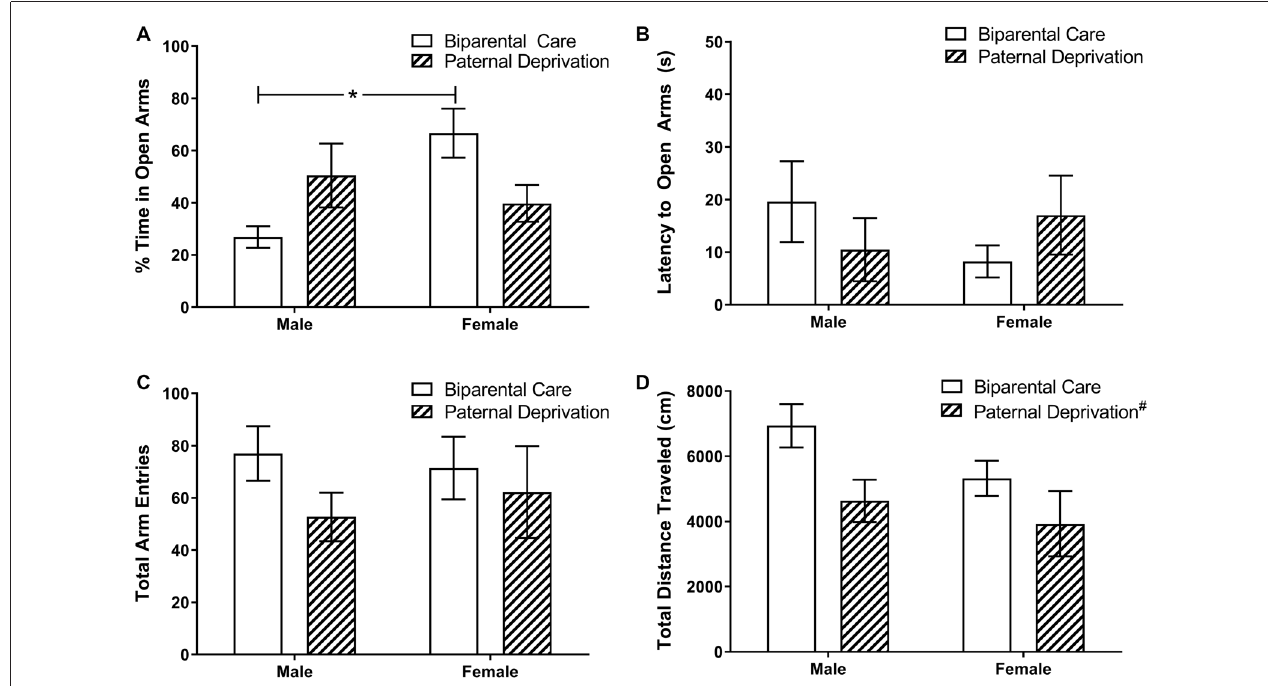
FIGURE 4 | Classic indices of anxiety-like behavior in the elevated plus maze are not altered by paternal deprivation (PD) among young adult California mice. Male and female California mice were reared by both parents (biparental care) or by the mother alone (PD) from postnatal day (PND) 1 until weaning. On PND 65, mice were tested on the elevated plus maze task for 5 min. (A) Among biparentally-reared offspring, females spent considerably more time on the open arms than males. PD did not alter time spent on the open arms. ∗ p ≤ 0.05. (B,C) Neither sex, nor rearing, altered latency to enter the open arms or total arm entries. (D) Irrespective of sex, total distance traveled within the elevated plus maze was reduced by PD. N sizes: biparental care male; 4; biparental care female, 7; PD male, 7; PD female, 5. Bars represent mean ± SEM. #, main effect of